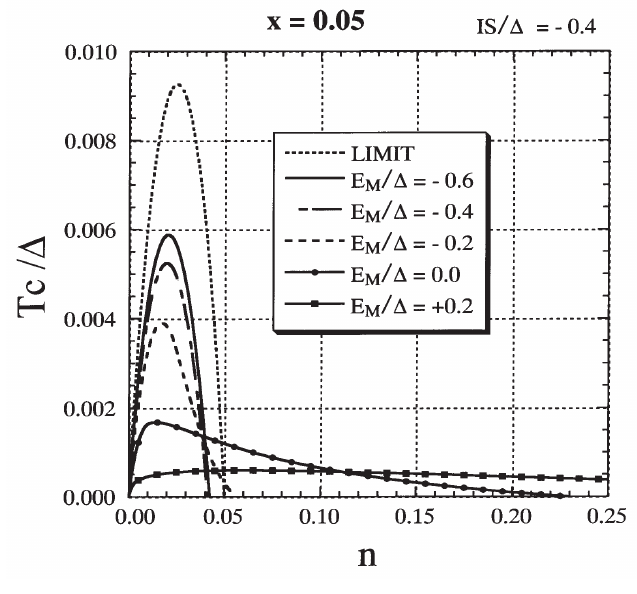
Figure 12. The result for T with x = 0 : 05 and IS = − 0 : 4∆ . The result denoted by ‘LIMIT’ is included (see text). From Takahashi and Kubo